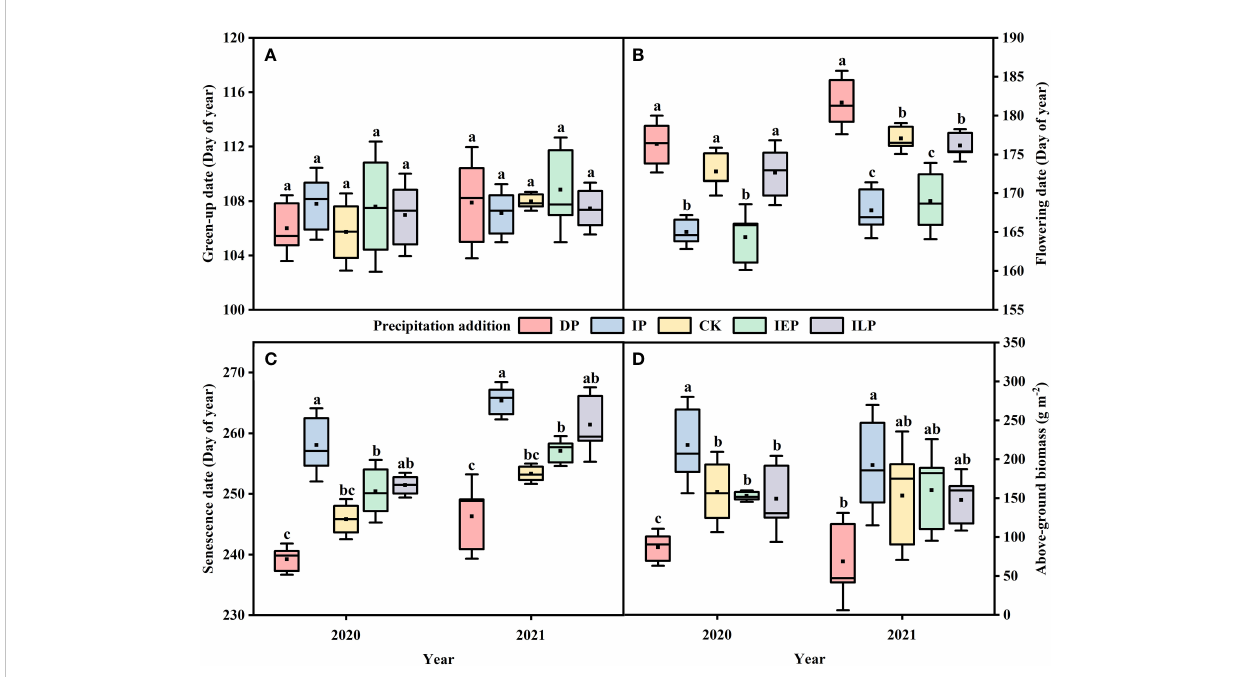
FIGURE 2 Effects of intra-annual precipitation patterns on community (A) green-up, (B) fl owering, (C) senescence, and (D) above-ground biomass from 2020 to 2021. The signi fi cance of each factor in different treatments was tested by one-way ANOVA. In Tukey ’ s HSD ’ s multi-range test, the different letters at the top of each box represent signi fi cant differences between different treatments (P < 0.05). Different colors represent the intra-annual precipitation treatment (n = 15, 5 individuals × 3 replicates). The boxes indicate the 25-75% con fi dence interval of each target variable. The solid lines and black squares inside the box represent the median and mean, respectively. Abbreviations are as in Figure